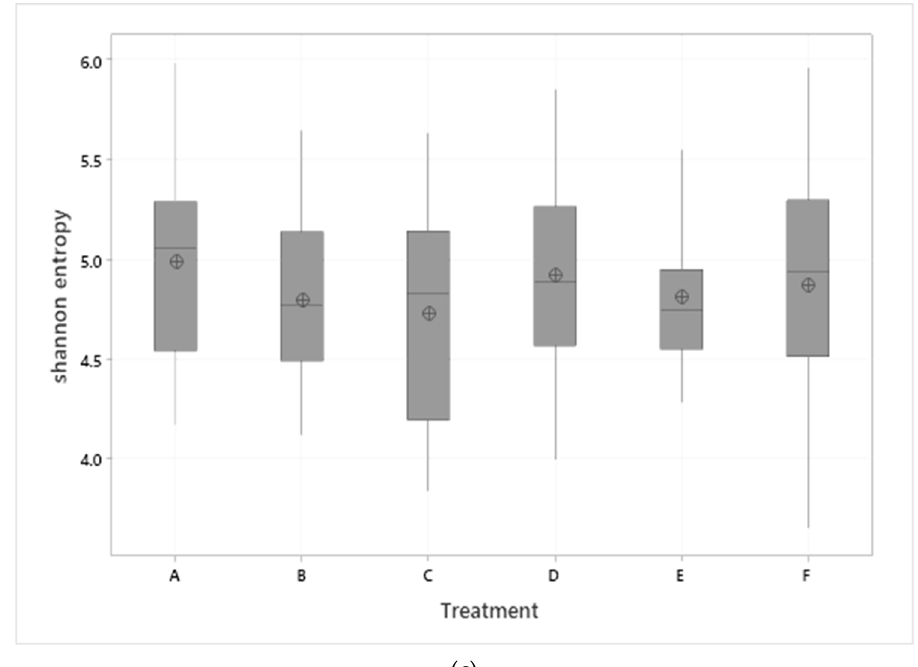
Figure 2. Alpha diversity (Shannon’s index) box plots show ( a ) significant difference between ileal and ceca microbiota (Kruskal–Wallis, p < 0.001), ( b ) no significant effect of treatments on ileal microbiota (Kruskal–Wallis, p > 0.05), ( c ) no significant effect of treatment on ceca microbiota (Kruskal–Wallis, p > 0.05). Treatments include (A) negative control treatment—chicks fed a basal corn-soybean meal-wheat-based diet; (B) in-feed antibiotics—chicks fed NC + 0.05% bacitracin methylene disalicylate and (C) in-water essential oil—chicks supplied the essential oil via the water route at the recommended dosage of 250 mL/1000 L of drinking water; (D) in ovo saline treatment—eggs injected with 0.2 mL of physiological saline (0.9% NaCl); (E) in ovo essential oil treatment—eggs injected with 0.2 mL of a saline + essential oil blend mixture at a dilution ratio of 2:1; and (F) in ovo + in-water essential oil treatment—chicks offered the essential oil blend via the in ovo and in water route, successively. Boxes in the boxplots denote interquartile range, solid middle line in the boxes denote the median, and ⊕ denote the means, Symbols ○ and * in ( a , b ) represent outliers.